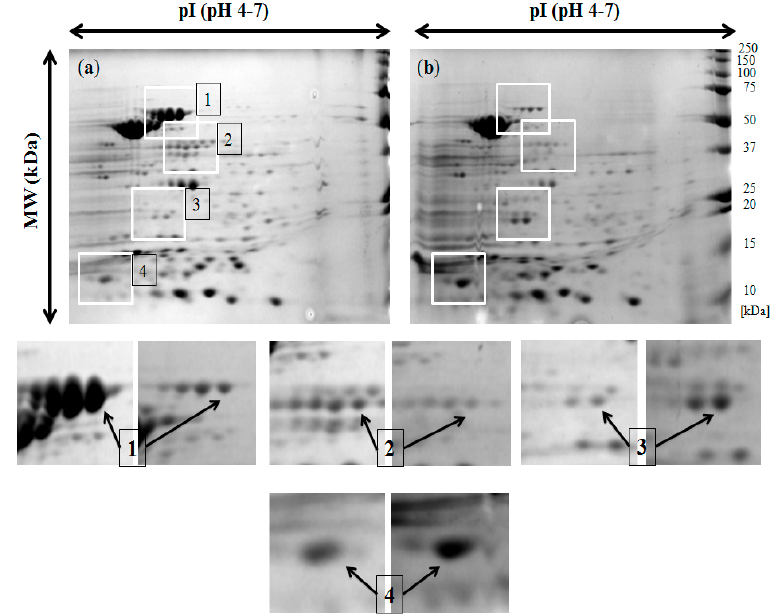
Figure 1. Comparative 2-D gel electrophoresis (pH 4–7) of OMPs from Salmonella Senftenberg 133 strain without biocide exposure ( a ) and with simultaneous resistance to triamine-containing disinfectant and NHS ( b ). Identification of flagellar protein FliC (Spot 1), enolase (Spot 2), chemotaxis response regulator protein-glutamate methylesterase (Spot 3) and outer membrane protein assembly factor (Spot 4). On the right, protein marker Precision Plus Protein™ Dual Color Standards 1610374 (Bio-Rad, Hercules, CA, USA). Left arrow refers to part ( a ), right arrow refers to part ( b ).